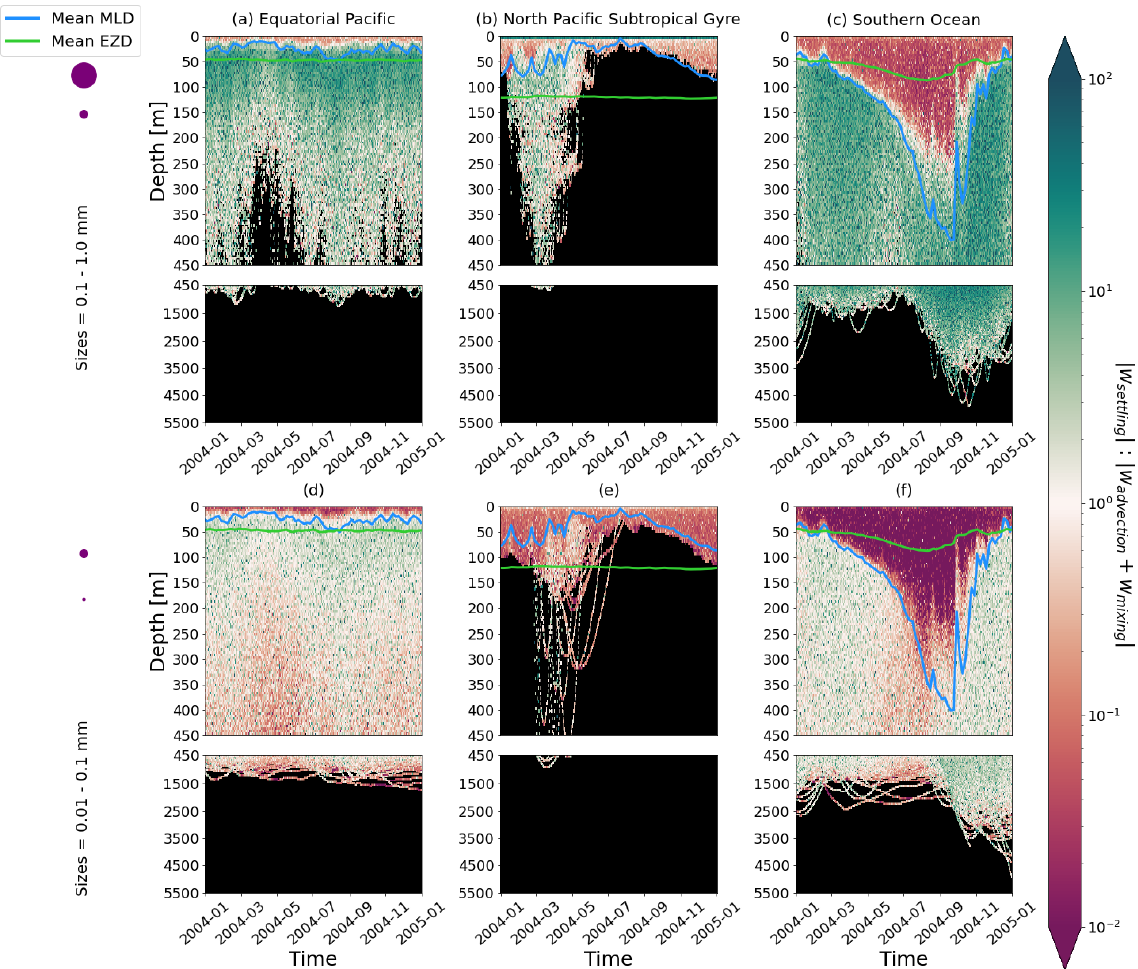
Figure 4. The ratio between a particle’s absolute settling velocity ( w settling or w s from Eq. 5) and the absolute ambient vertical velocity of mixing plus advection ( w advection + w mixing or w m from Eq. 3) for each 1-year trajectory from Fig. 2. Green patches represent instances where the particle’s settling velocity dominates the vertical displacement of a particle, whereas red patches represent instances where physical ocean dynamics dominate. The same simulation duration, depth range, three regions, two size classes, and MLD and EZD as in Fig. 2 are